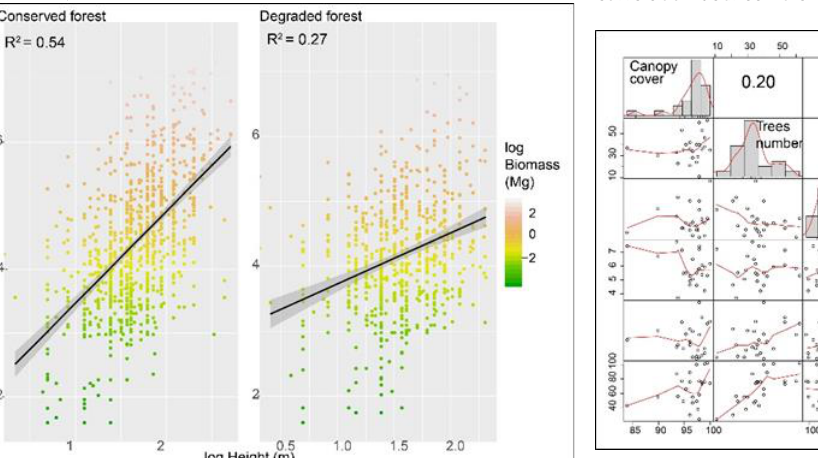
Figure 4. Kendell’s tau correlation only for conserved forest plots